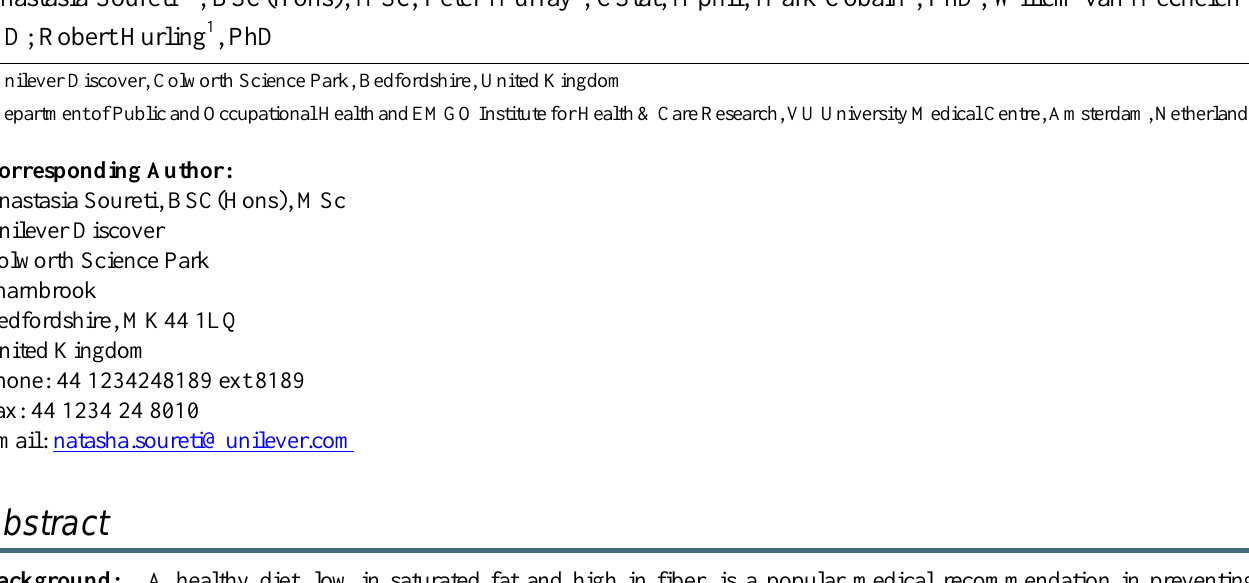
Risk perceptions; cardiovascular disease; planning; saturated fat